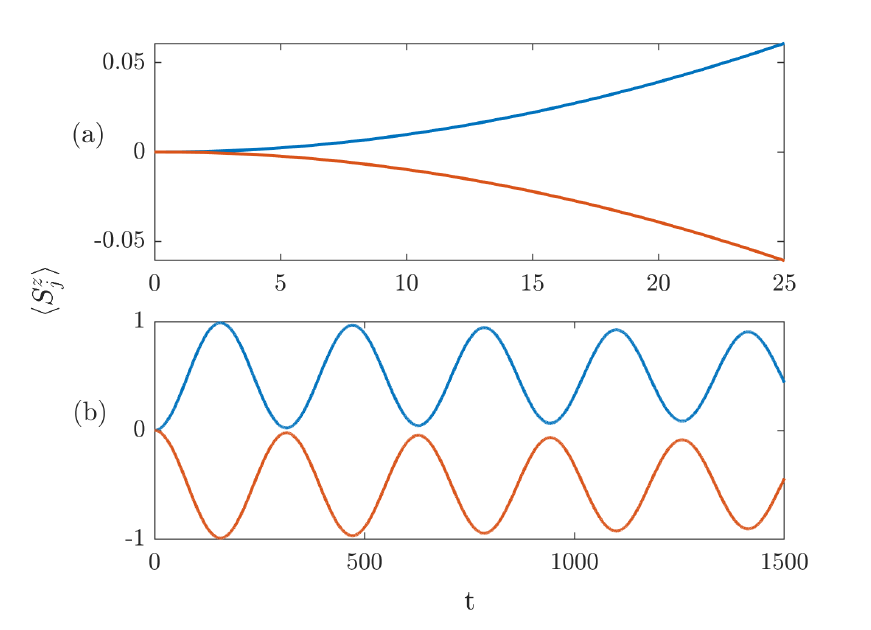
Figure 6: Evolution of S z observable on sites A (blue) and B (red) for the Spin-1, inverted limit cycle model with ω = γ = 1, µ = 0.0001, ε = 0.01. In (a) we